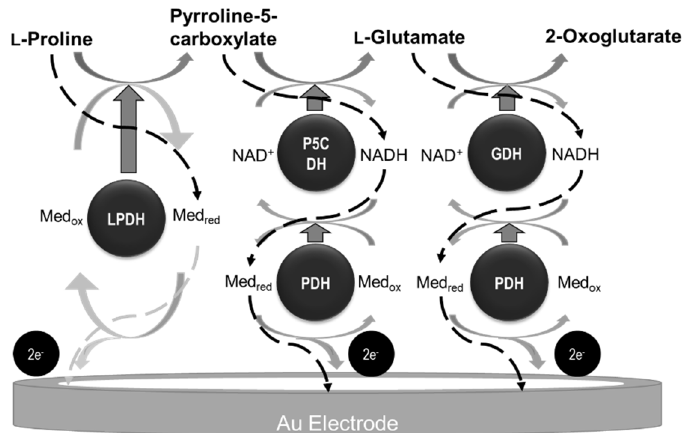
Figure 1. Scheme of cascade reaction in the present study.